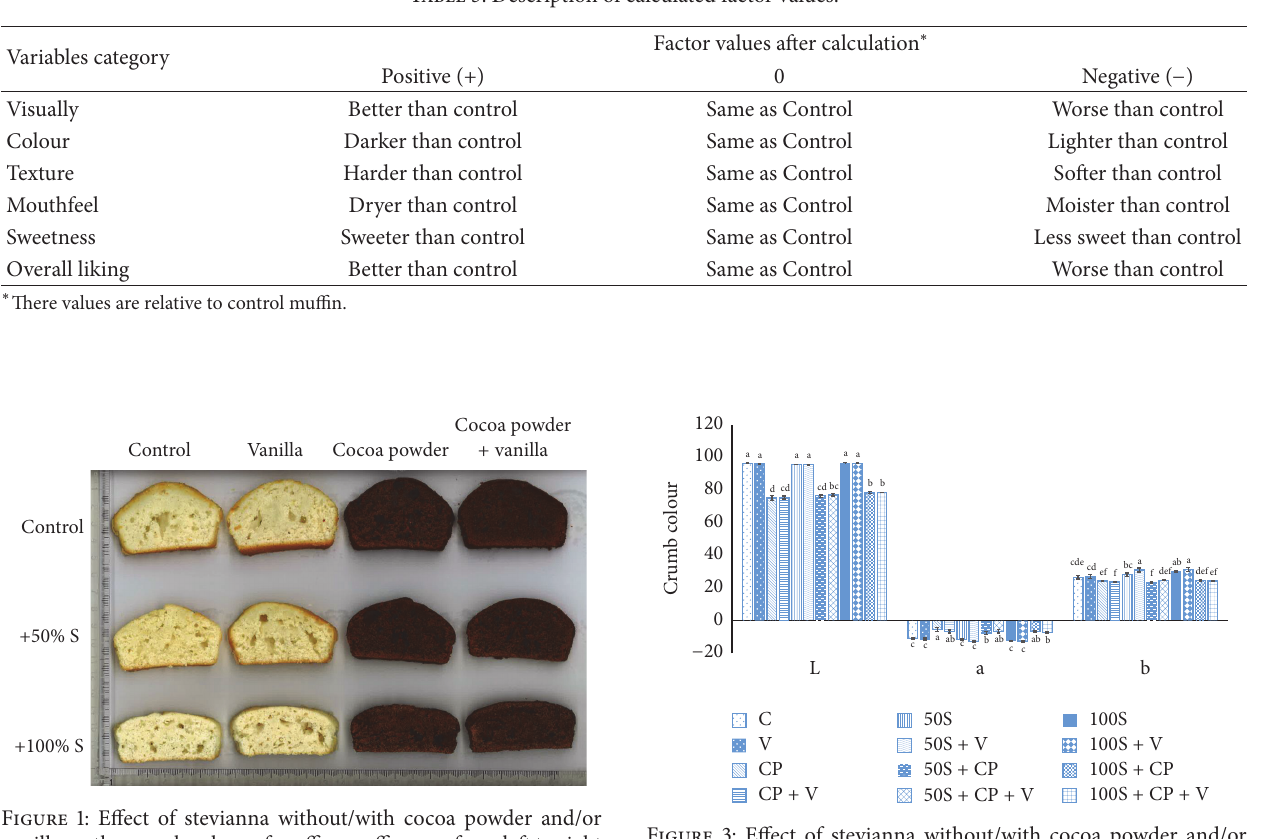
Table 3: Description of calculated factor values.